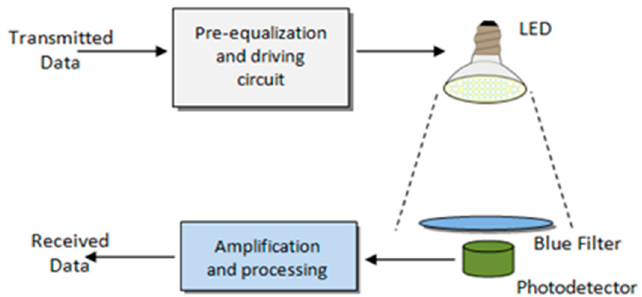
Figure 7. The simplified visible light communication (VLC) system block diagram.